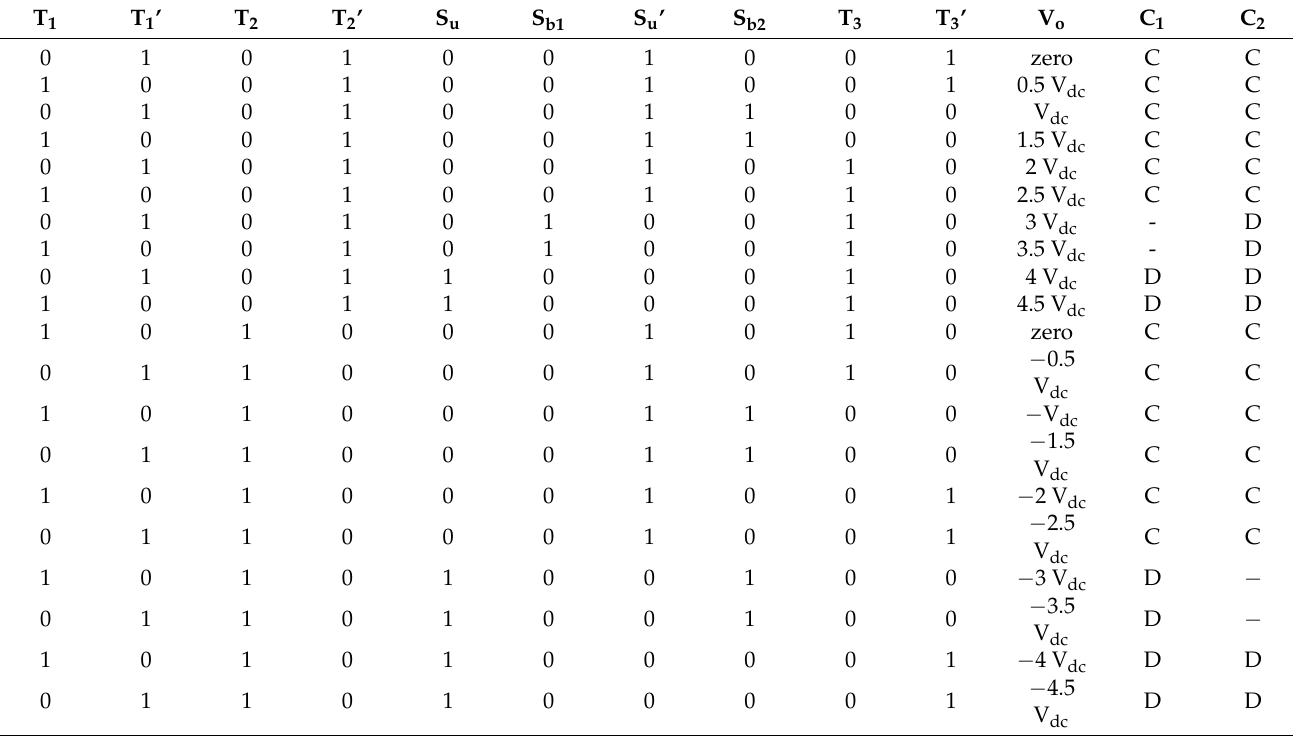
Figure 2. All positive conduction states.